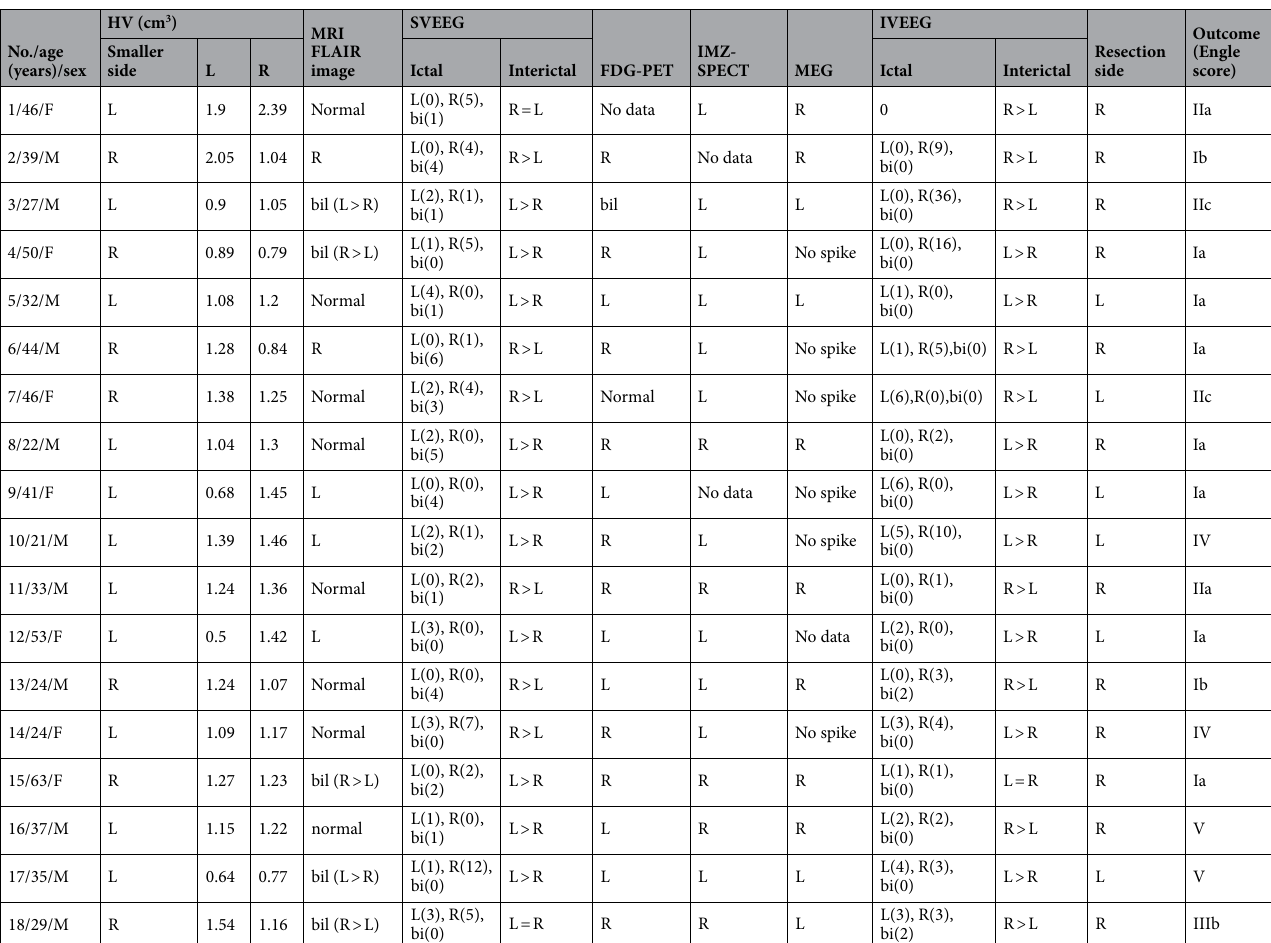
Table 3. Resection side diagnosis at each evaluation and surgical outcome. F, female; M, male; L, left; R, right; bil, bilateral; HV, hippocampal volume; SVEEG, scalp video electroencephalograph; FDG-PET,